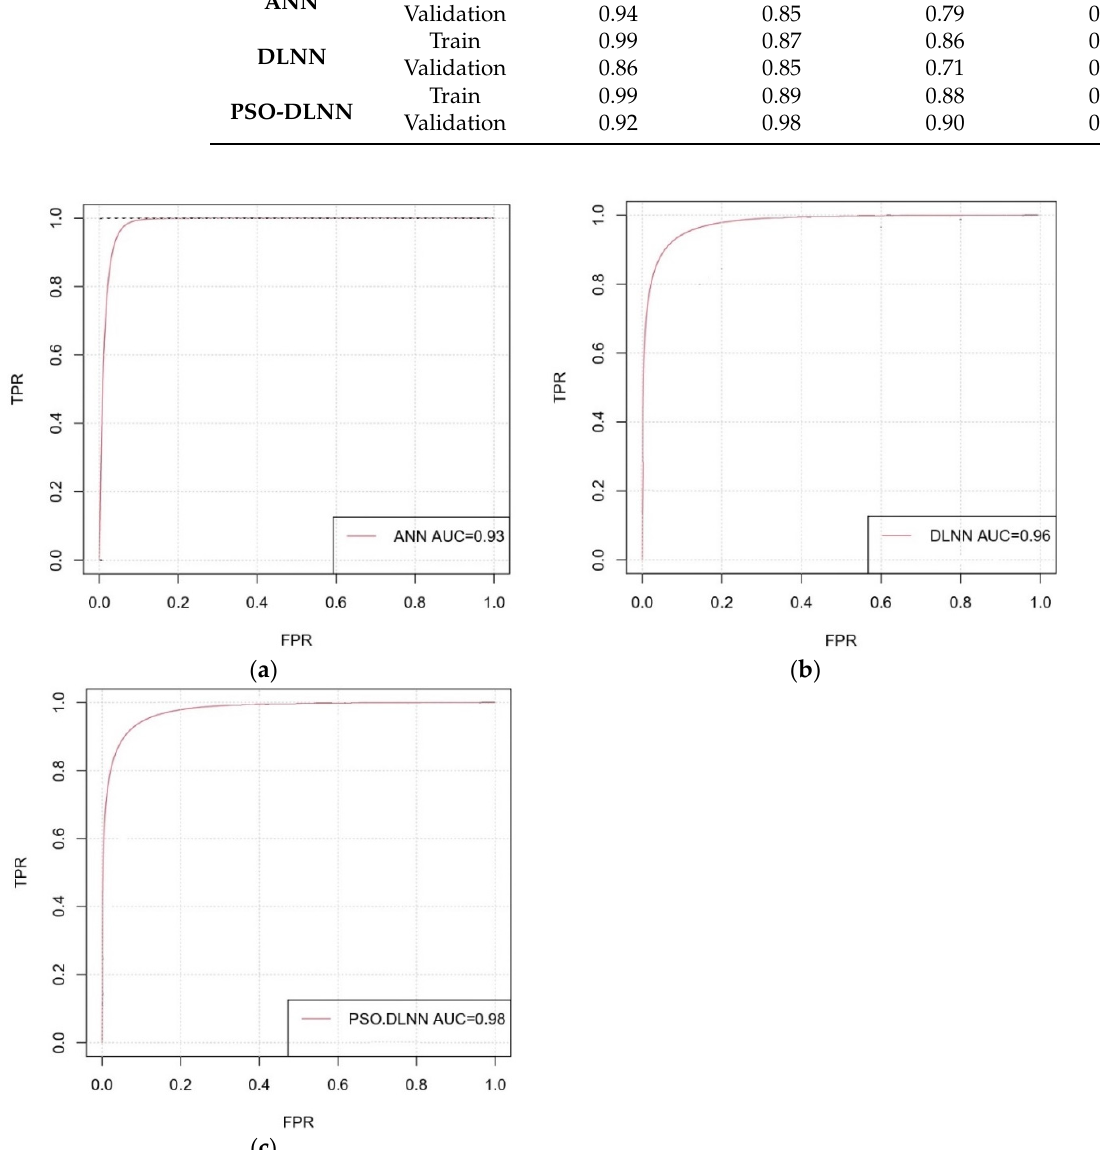
Figure 8. Evaluation of the flood susceptibility maps based on the AUC test ( a ) ANN, ( b ) DLNN, and ( c ) PSO-DLNNO. The results of variable importance for PSO-DLNNO are provided in Table 7. Accord- ingly, the most important factor was altitude, followed by the distance from the river. STI, slope, and distance from the road were the third, fourth, and fifth ranked in terms of their significant effects on the flood occurrence in the region. Additionally, SPI seems to have no contribution to the susceptibility mapping and was ranked 13th. Table 7. Variable importance analysis derived from PSO-DLNN model. Variables